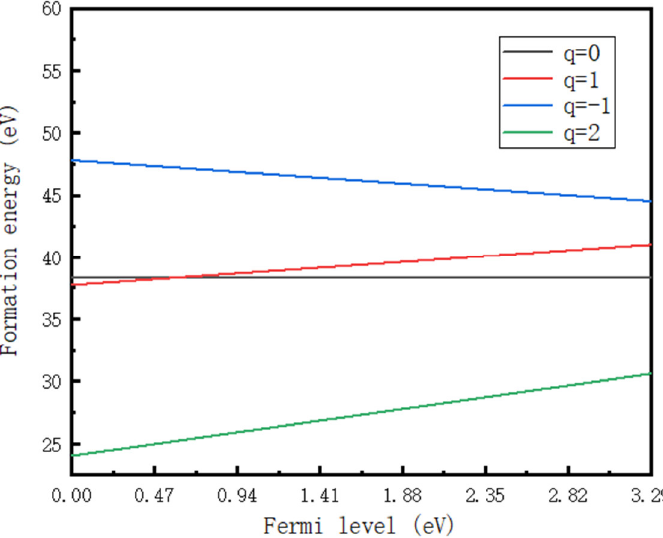
Figure 10. Formation energy for Si c (C si ) 2 in 4H-SiC.